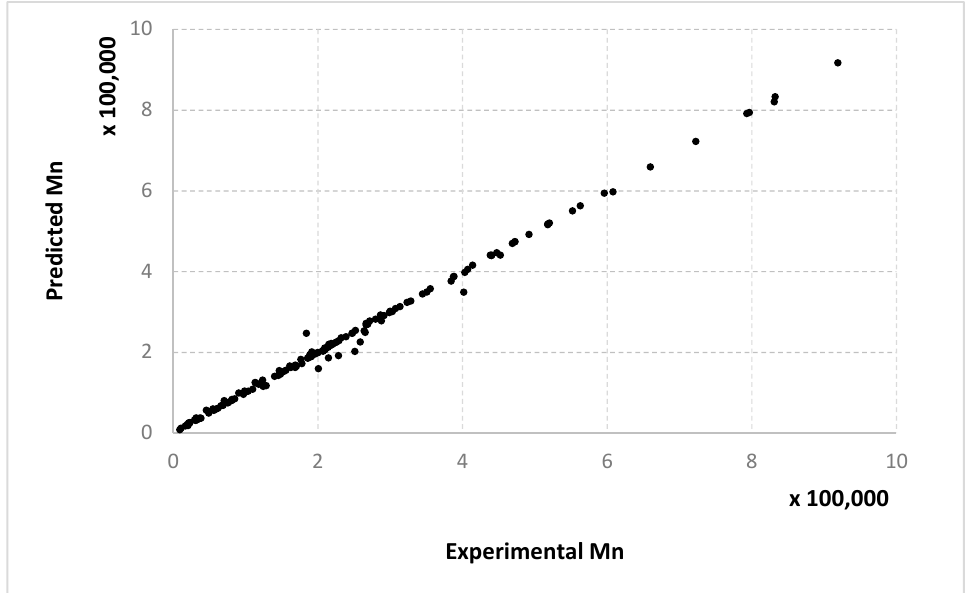
Figure 8. Predicted numerical average molecular weight with the RADIAN algorithm versus experimental data, setting 1, with data split into 90% for training and 10% for testing.